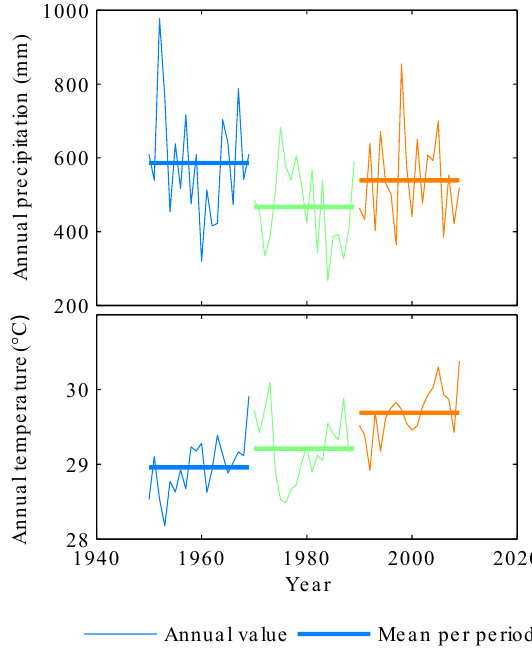
Figure 1. Annual and 20-year mean precipitation and temperature at Niamey airport, Republic of Niger (1950–2009). The three clima- tologically distinct periods (1950–1969; 1970–1989; 1990–2009) are noted (respectively in blue, green and